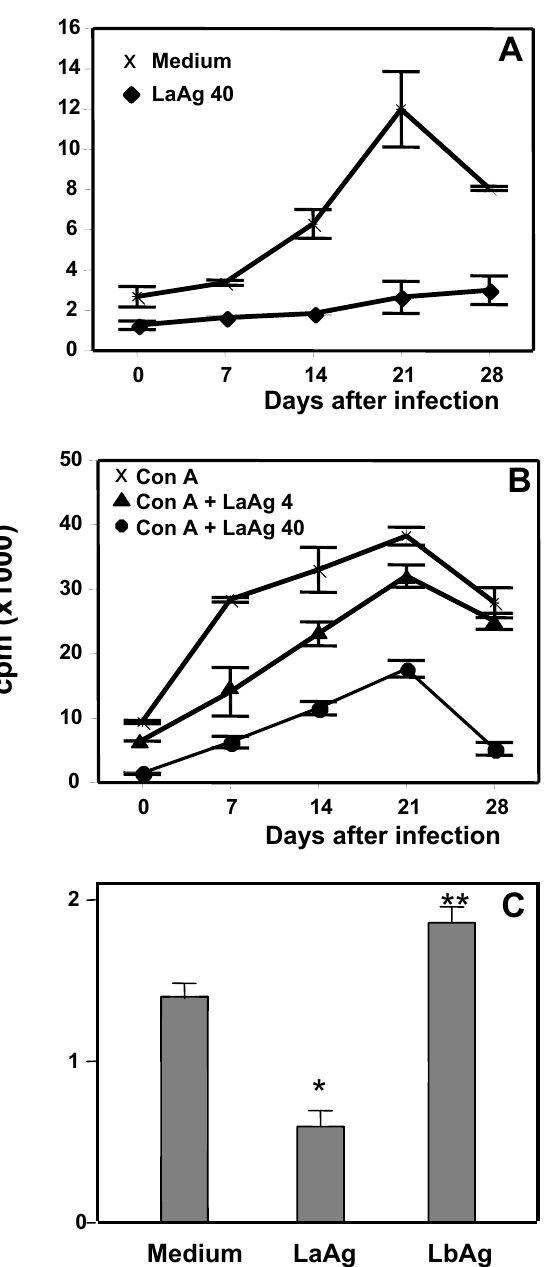
Fig. 1 – LaAg- induced suppression of cell proliferation during the course of infection. Groups of BALB/c mice at different times of infection with L. amazonensis were sacrificed and their lesion-draining lymph node cells obtained. The spontaneous (A) or Con A-induced proliferation (B) was measured in the presence of the indicated concentrations of LaAg. In (C), cells from 7-day infected mice were re- stimulated with 40 µ g/ml of LaAg or LbAg. Mean ± SD (n=3). Asterisks indicate (*) p ≤ 0 . 01 and (**) p ≤ 0 . 05 in relation to